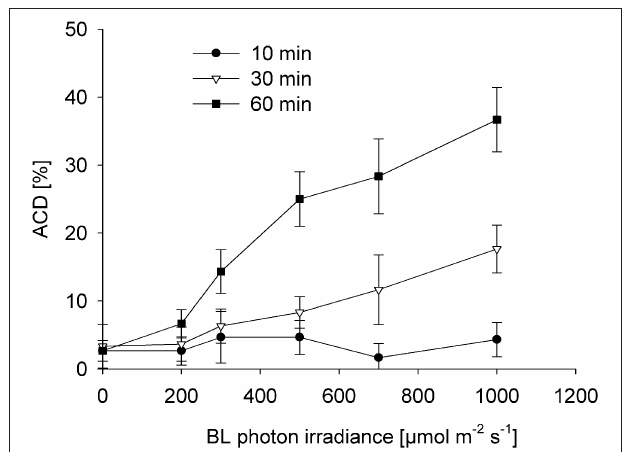
FIGURE 4 | Induction of altered chloroplast distribution (ACD) in Coscinodiscus granii after 10, 30, and 60min of exposure to increasing BL photon irradiance levels. Average values and standard error ( n = 3 ) are